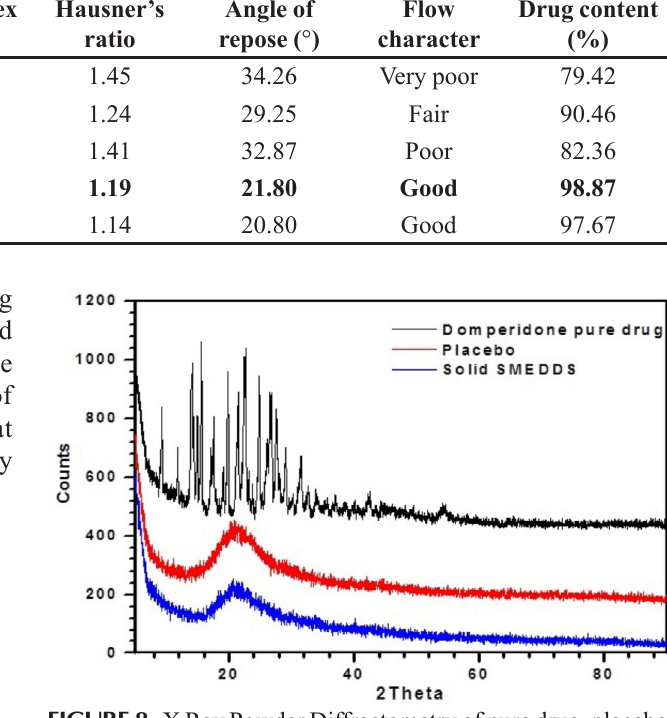
FIGURE 8- X Ray Powder Diffractometry of pure drug, placebo and batch